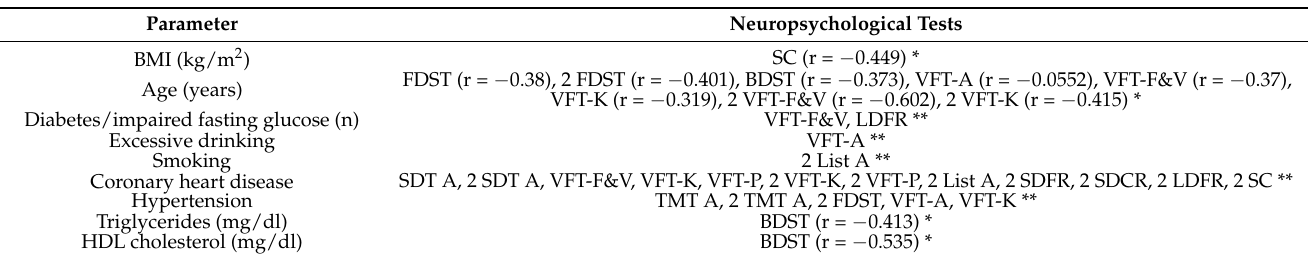
Table 8. Correlations between the results of neuropsychological tests and demographic factors and